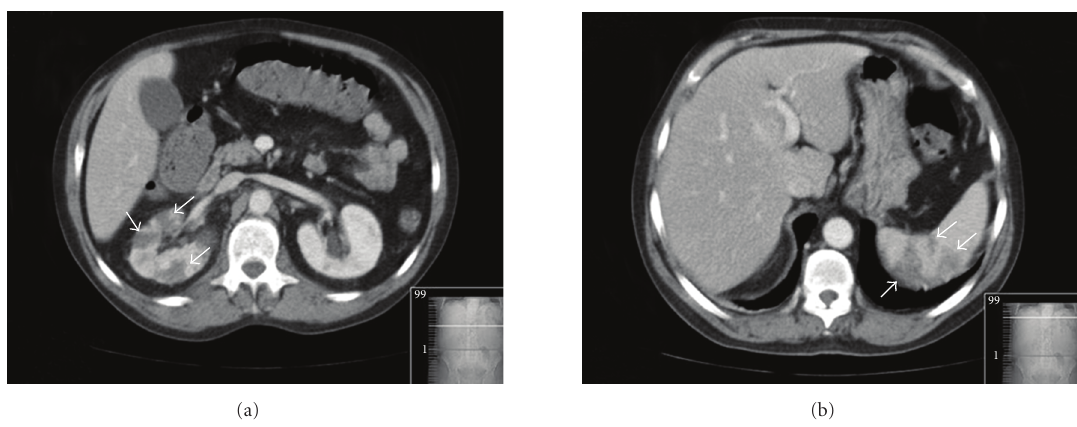
Figure 1: Abdominal computed tomography scan showing multiple ischemic areas ( arrows ) in the right kidney (a) and in the spleen (b), suggesting an embolic source.